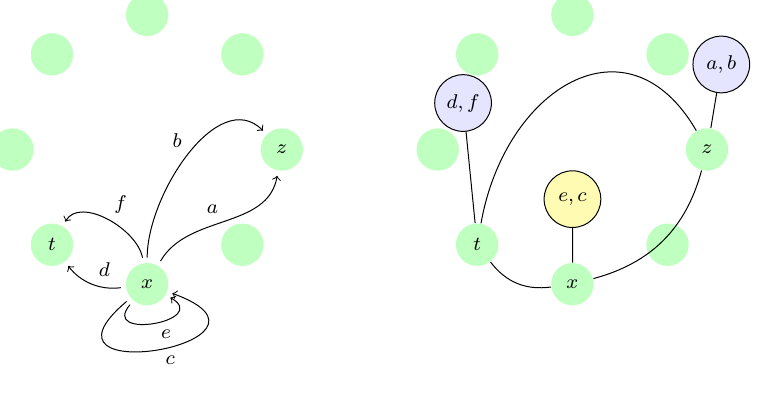
Fig. 4. If stabilizer x , shown on the left as self-loops over x , has two elements { e,c } , then every z ∈ orbit x is reachable by two group elements: z = a ◦ x = a ◦ ( c ◦ x ) = ( a × c ) ◦ x = b ◦ x where b = a × c , and b (cid:54) = a since c (cid:54) = e . On the right are shown the two group elements for every point in orbit x inside its “balloon”. The balloon over x is stabilizer x ; the other balloons are cosets of stabilizer x .